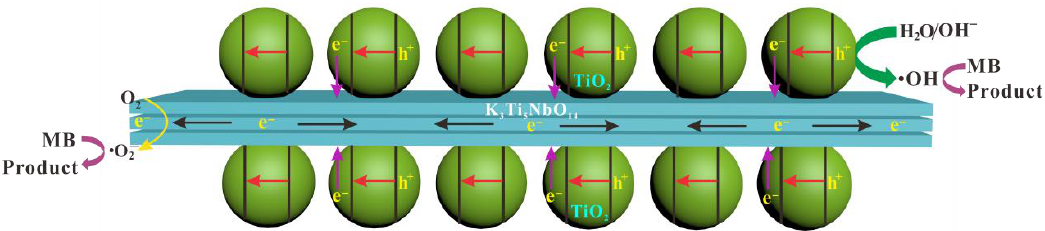
Figure 12. A schematic illustration of the STNT composite for the photodegradation of methylene blue (MB).